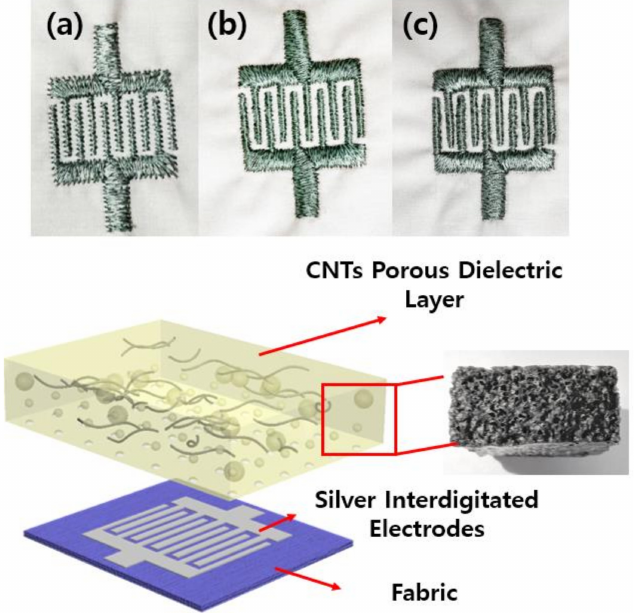
Figure 6. Schematic diagram of the fabricated pressure sensor ( a ) Low density, ( b ) medium density, ( c ) high density.